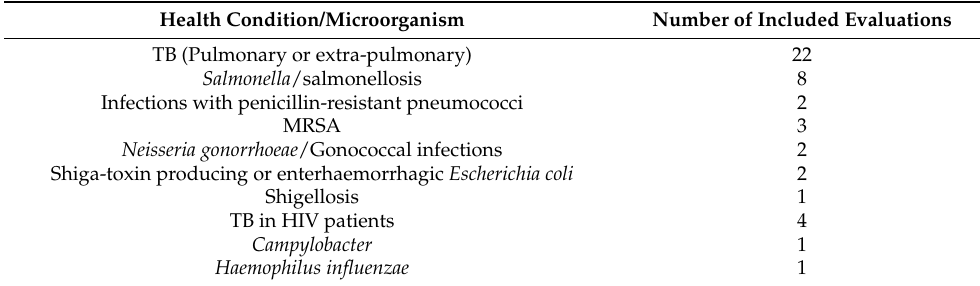
Table 4. Antimicrobial resistance (AMR)-related health conditions and microorganisms monitored